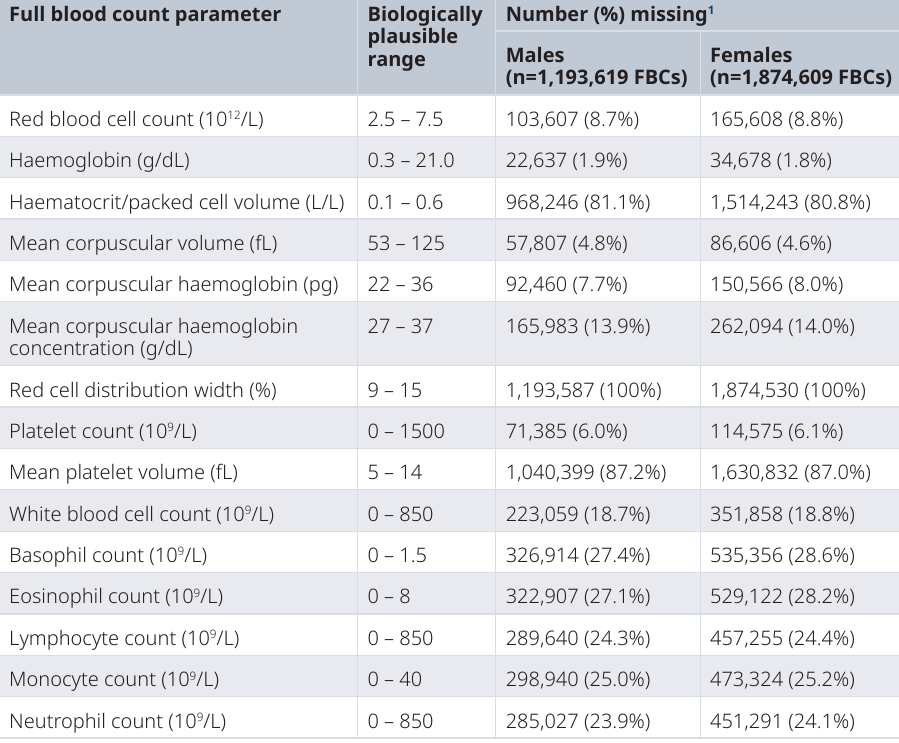
Table 3. Details of the full blood count blood test parameters included in the